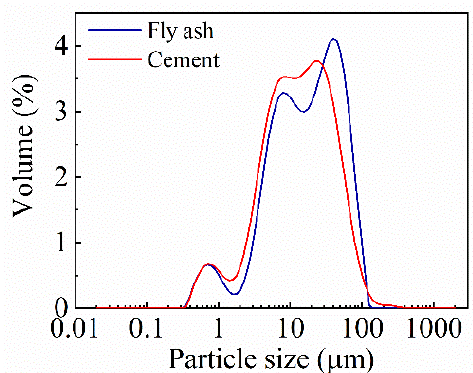
Figure 2. Particle size distribution of binder materials.